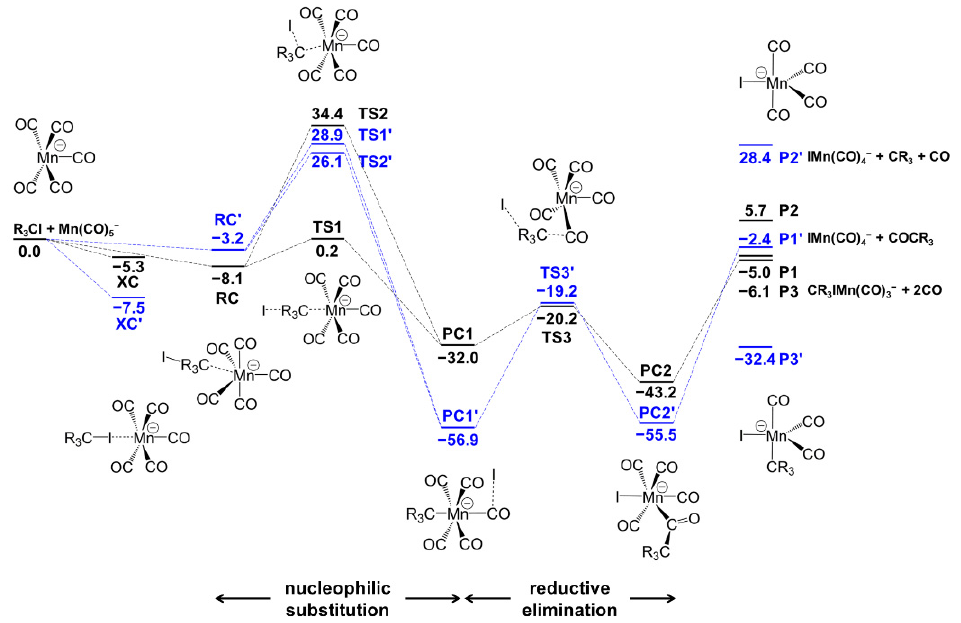
Figure 3. Enthalpy and free energy values at 298.15 K are listed in Table 1.